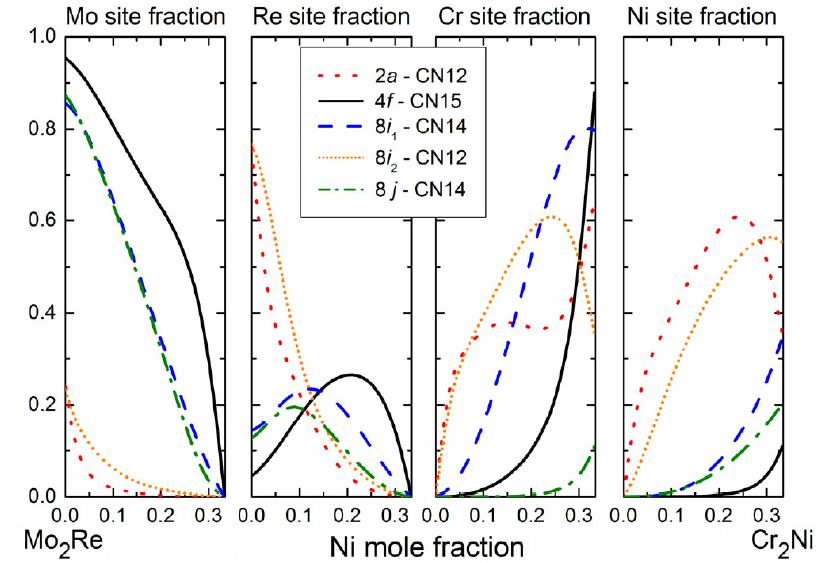
Figure 16. Calculated site occupancies for the σ phase at 1227 °C between Mo 2 Re and Cr 2